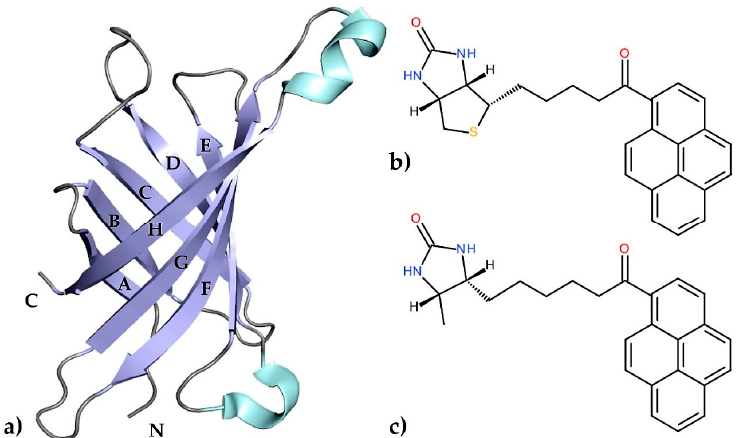
Figure 1. ( a ) An illustrated representation of the topology of avidin. The central eight-stranded antiparallel β -sheet, α -helixes, and loops are colored blue, cyan, and grey, respectively; ( b ) A schematic diagram of 1-biotinylpyrene (B9P) and ( c ) 1-desthiobiotinylpyrene (D9P).